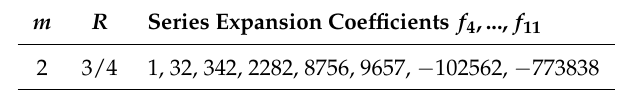
Table 2. Coefficients of series expansion of f ( D ) for the RS convolutional code of rate R = 3/4. m R Series Expansion Coefficients f 4 ,..., f 11 2 3/4 1, 32, 342, 2282, 8756, 9657, − 102562, −